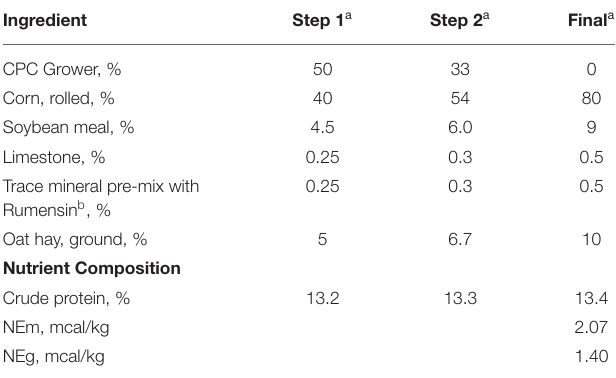
TABLE 1 | Composition of the high concentrate diet fed to steers in this study. Ingredient Step 1